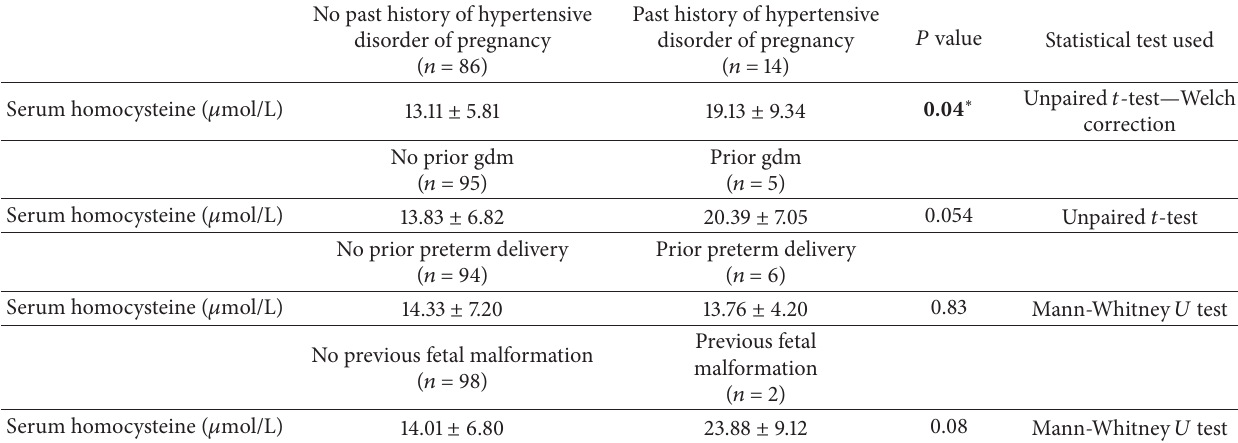
Table 1: Homocysteine levels with reference to outcome of past pregnancies.